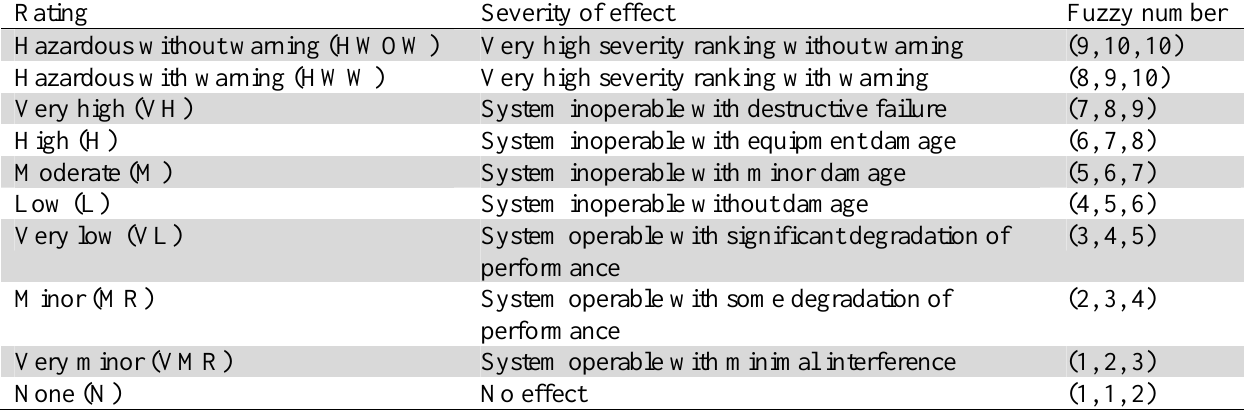
Fuzzy ratings for severity of a failure (Chin et al., 2008; Wang et al., 2009) Rating Hazardous with warning (HWW)